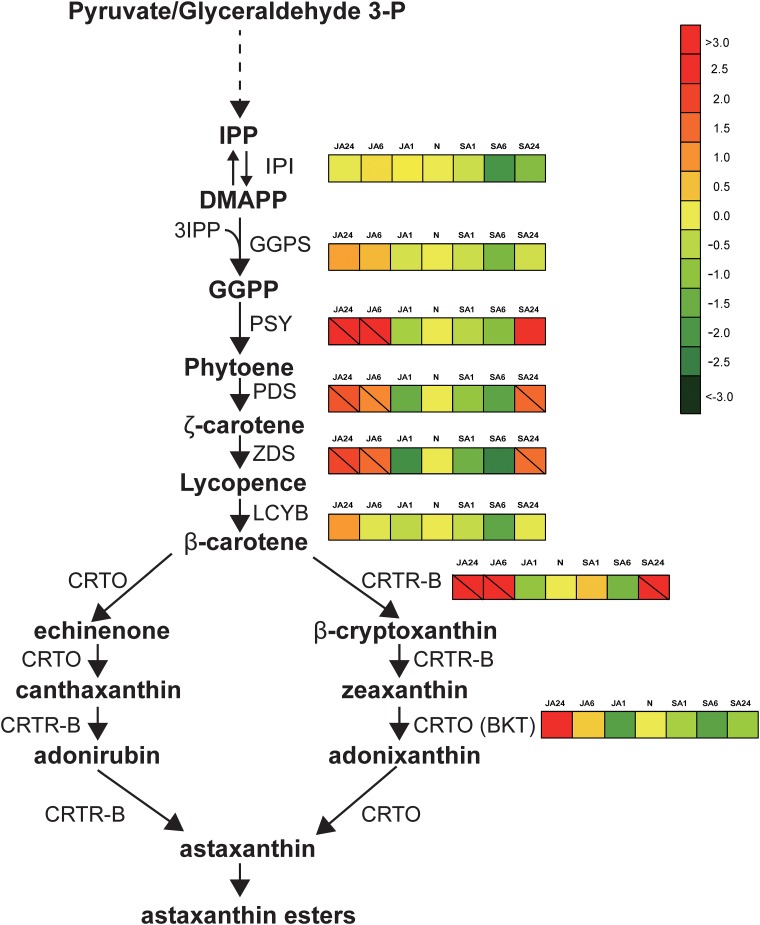
Differential epression of genes involved in the carotenoid biosynthesis pathway ofHaematococcus pluvialis.The color chart represents up- (red) and down-regulated (green) folds. The slash in the square indicates a significant differential-epression at the level of > 2 folds, FDR < 0.001, RPKM > 20. IPI- isopentenyl diphosphate isomerase; GGPS- geranylgeranyl diphosphate synthase; PSY- phytoene synthase; PDS- phytoene desaturase; ZDS- zeta-carotene desaturase; LCYB- lycopene beta-cyclase; CRTR-B- carotenoid hydroylase; BKT/CRTO- beta-carotene ketolase.